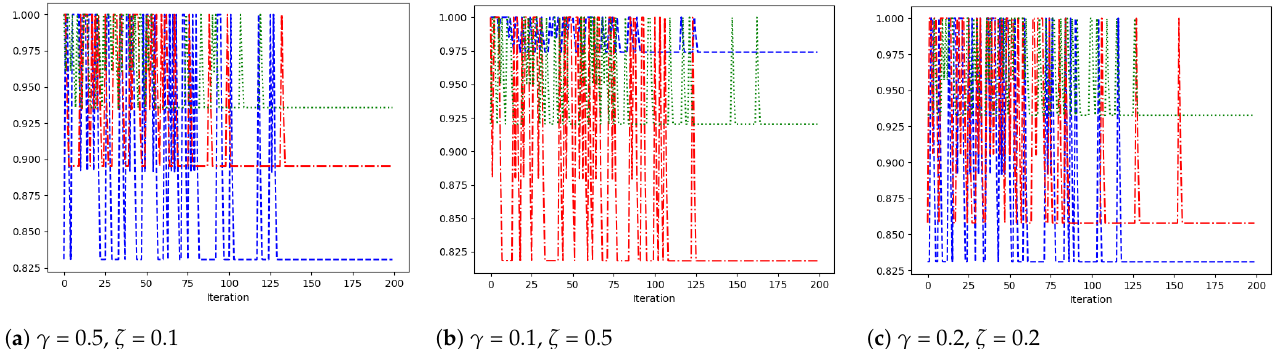
Figure 9. Convergence behaviour of average reward function for multiple user populations (small (blue), medium (red), large (green)).